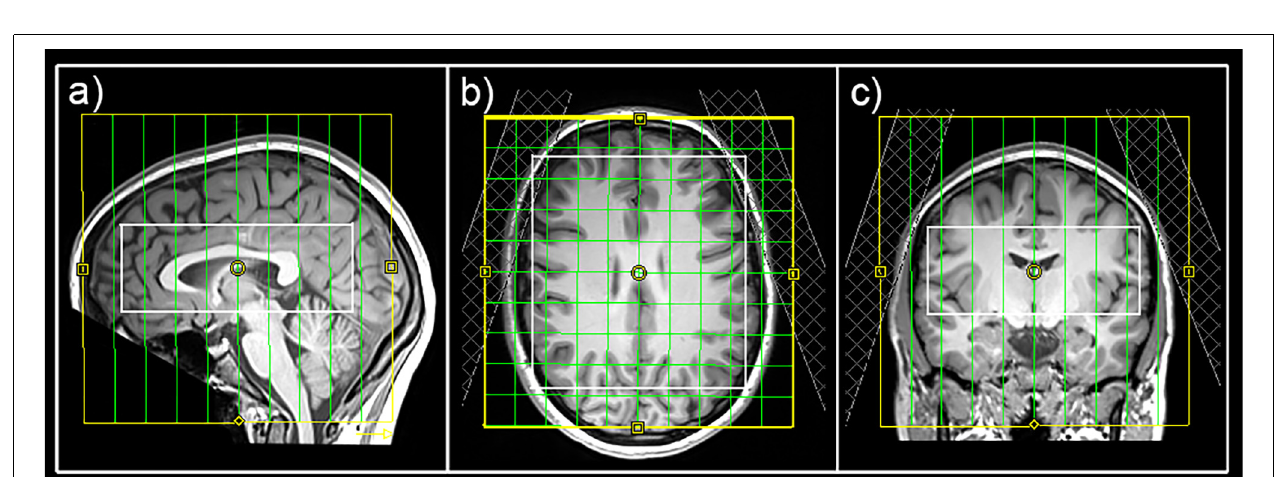
LCModel software (6.3-1, S. Provencher, LCModel, Oakville, ON, Canada) was used for the quantification of all spectra within the VOI (Spurny et al., 2019). A simulated basis set was created using the GAMMA library for the difference spectrum [containing GABA+, Glx, and tNAA among others (Hnilicova et al., 2016)]. An exemplary spectrum is shown in Supplementary Figure 1 . Cramér–Rao lower bounds (CRLB) thresholds were set at 30% and spectra were visually